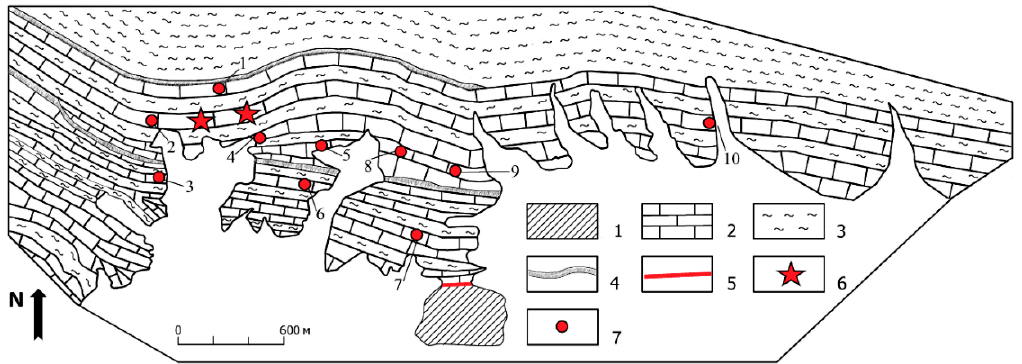
Figure 2. Geological map of the southwestern limb of the Shatput anticline modified after [8]. Geomorphologically, this is the southern slope of the Tura–Kuloma ridge. 1—Triassic system (lines indicate the strike of rocks; azimuth of dip is to the southeast). 2–4—Sarydzhilgin suite (sub-